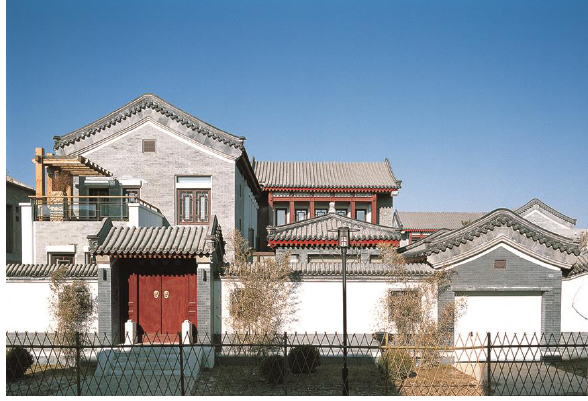
Figure 13. A closer view of a Guantang courtyard garden villa with traditional enclosing walls, gate, and modern garage. Source: Beijing Institute of Architectural Design 2014.